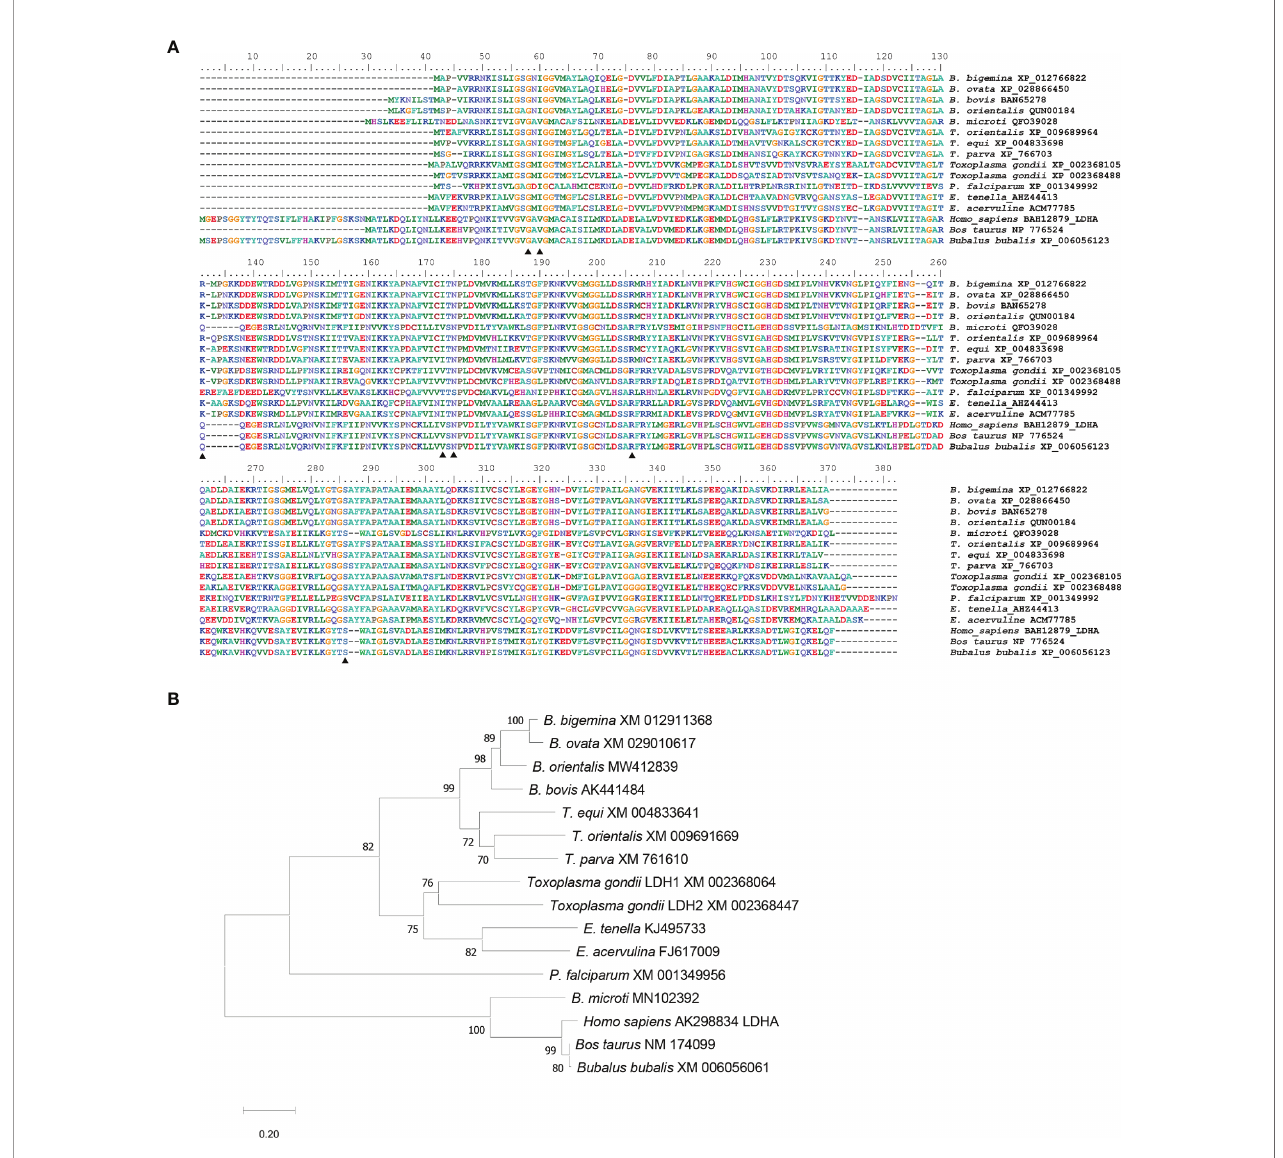
FIGURE 1 | Multiple alignments and phylogenetic analysis. (A) Multiple alignments of LDH amino acid sequence by MAFFT version 7. Thirteen apicomplexan parasites sequences and three mammalian host sequences were compared. GenBank accession numbers were followed after species names. B, Babesia ; T, Theileria ; P, Plasmodium ; E, Eimeria . Similar amino acids are shown in gray; identical amino acids in black triangles indicated the predicted residuces for inhibitor gossypol. (B) Phylogenetic analysis of LDH nucleotide sequences from 13 apicomplexan parasites and 3 mammalian hosts. The optimal tree is calculated by neighbor-joining with bootstrap estimates from 1,000 replicates. Evolutionary distances showed with the scale with branch lengths in the same units infer the phylogenetic